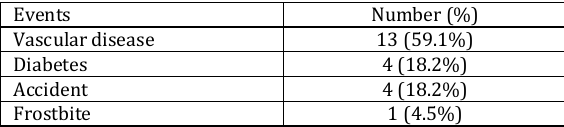
Table 1. Events leading to amputation in the group (N = 22)